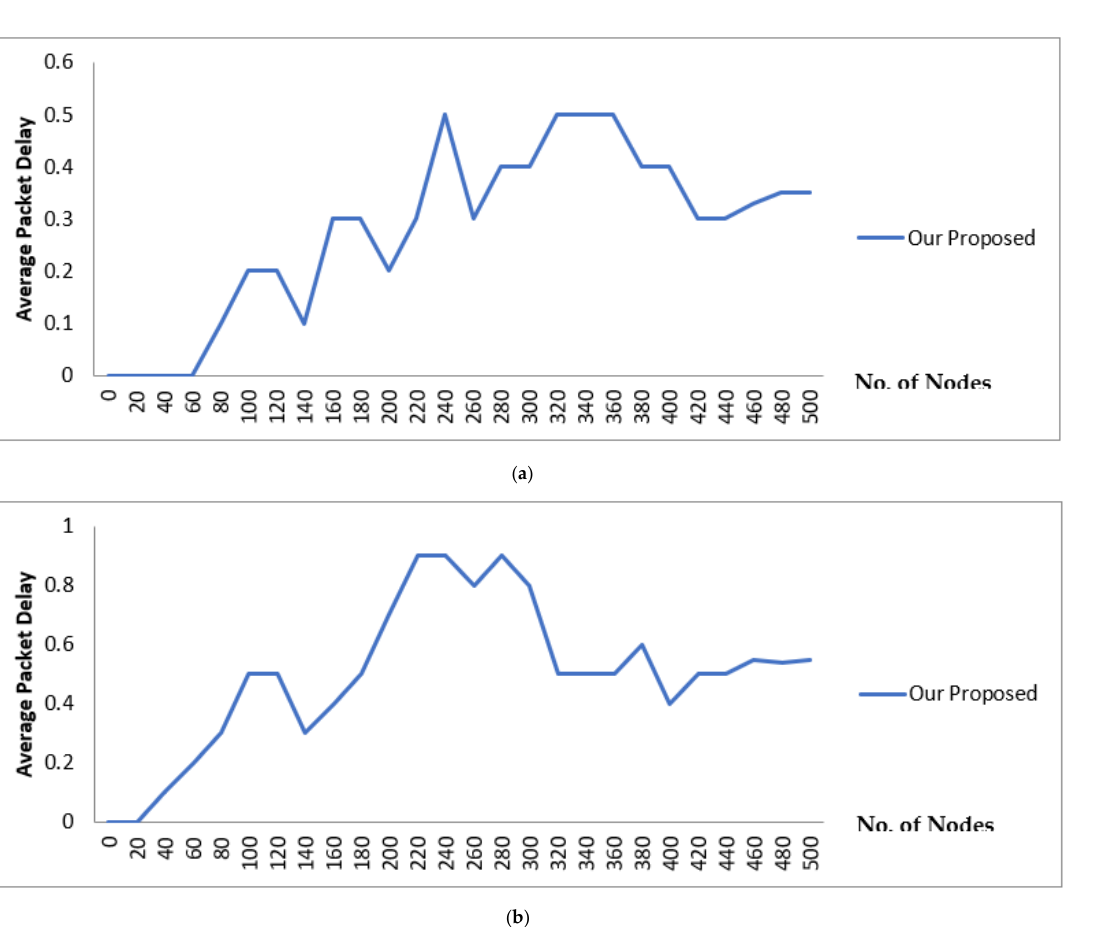
Figure 8. ( a ): Average Delay without Eclipse Attack; ( b ): Average Delay with Eclipse Attack.